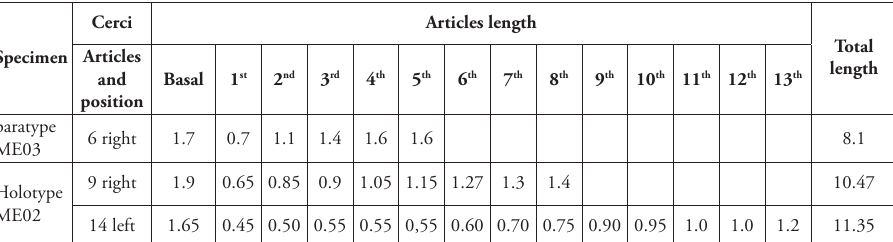
Table 2. Pacificampa daidarabotchi Sendra, sp. n., cercal articles length and total length (units in mm) including number of articles of each